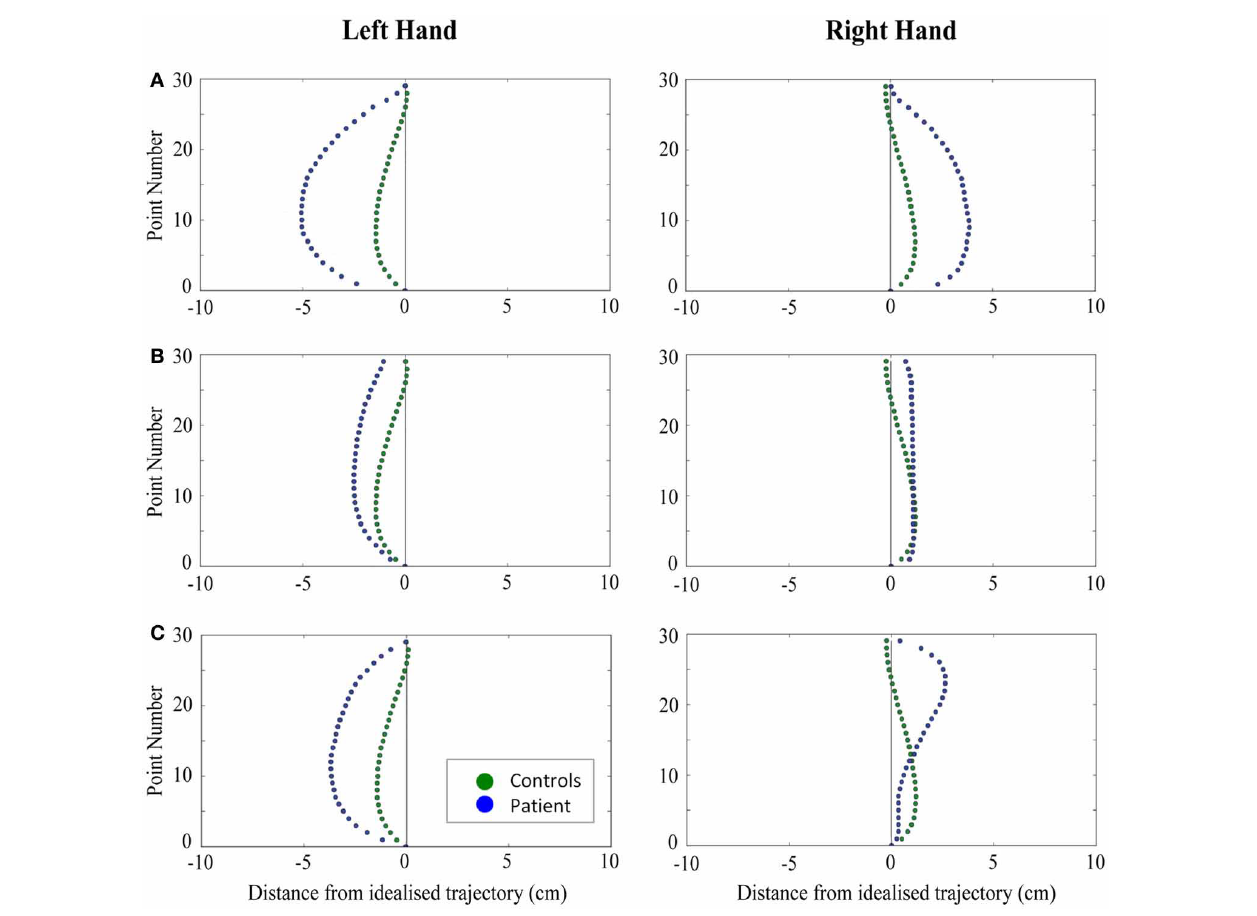
FIGURE 4 | A comparison of standardized reach paths for controls vs. patients—(A): patient RB, (B): patient SS, and (C): patient AP—when grasping objects at midline with both the right and left hands in Experiment 2.